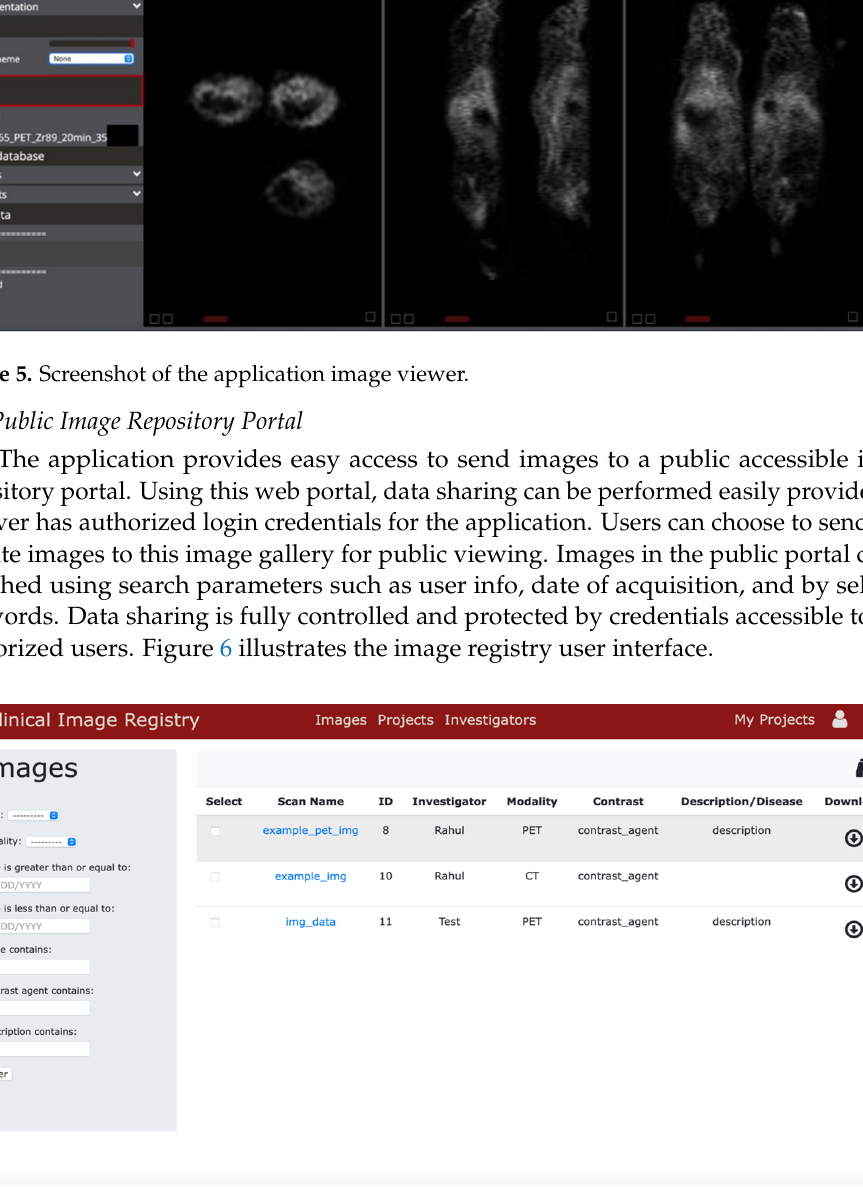
Figure 6. Screenshot of the public image registry or global image gallery.